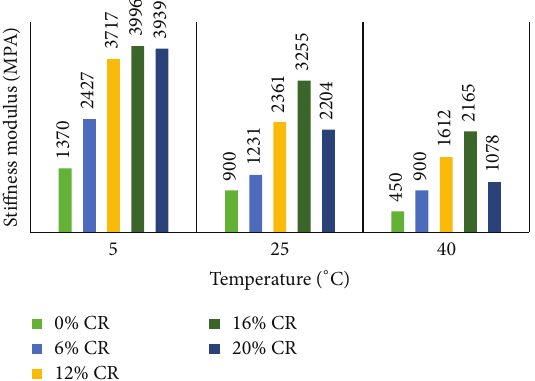
Figure 3: Stiffness modulus versus temperature.